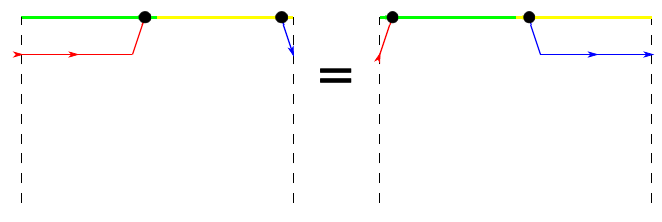
Figure 5 . The KT